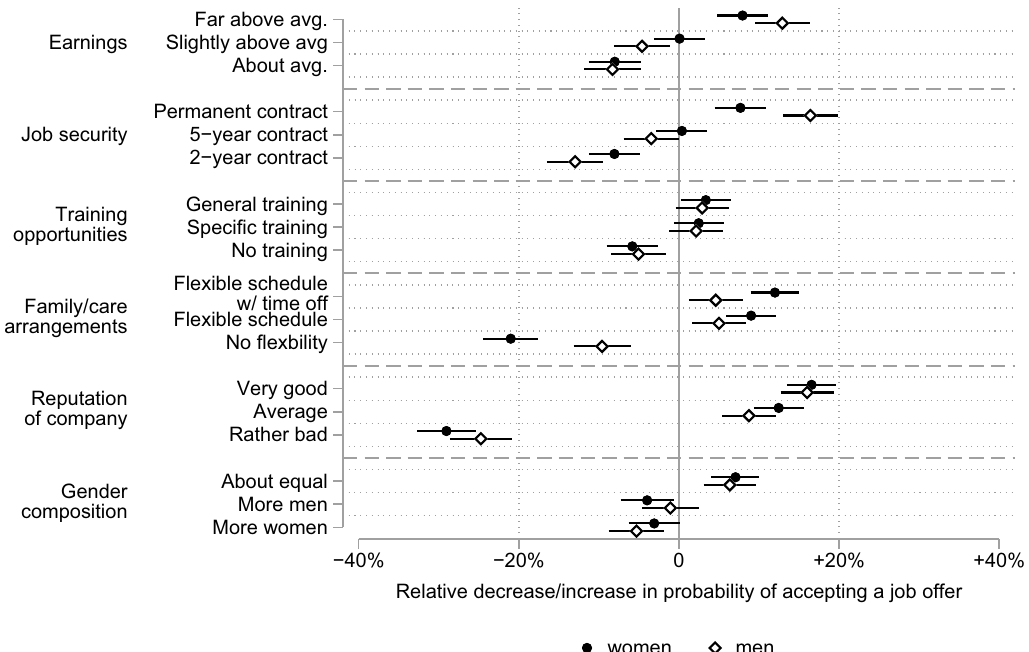
Fig 4. Preferences for job attributes among male and female respondents in the Dutch survey. The figure shows the relative decrease/increase in probabilities (with 95% confidence intervals) of choosing a job due to the respective job